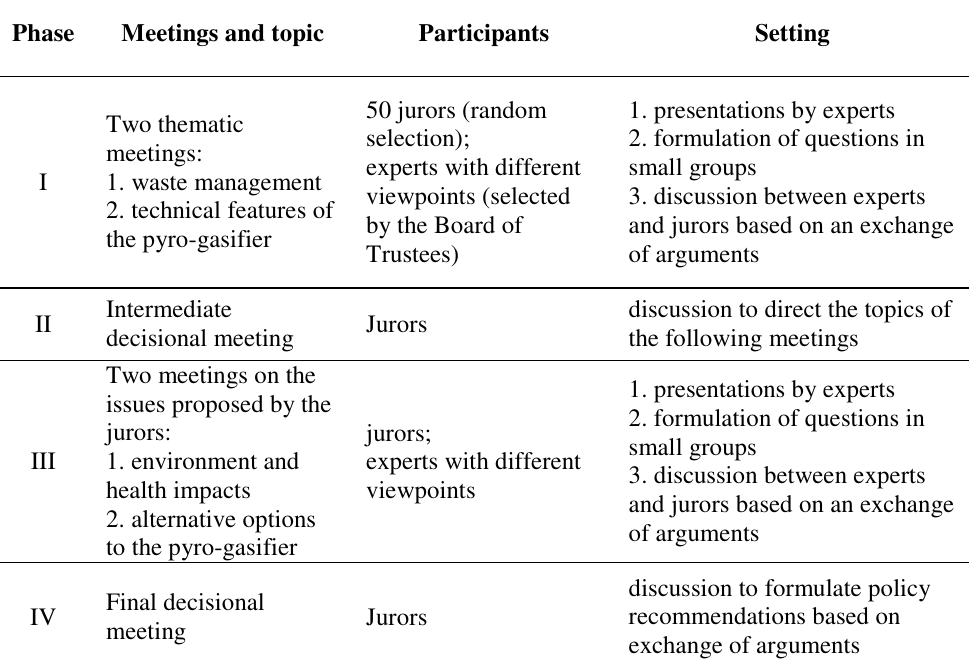
Table 2. The Design of the Tuscan Process